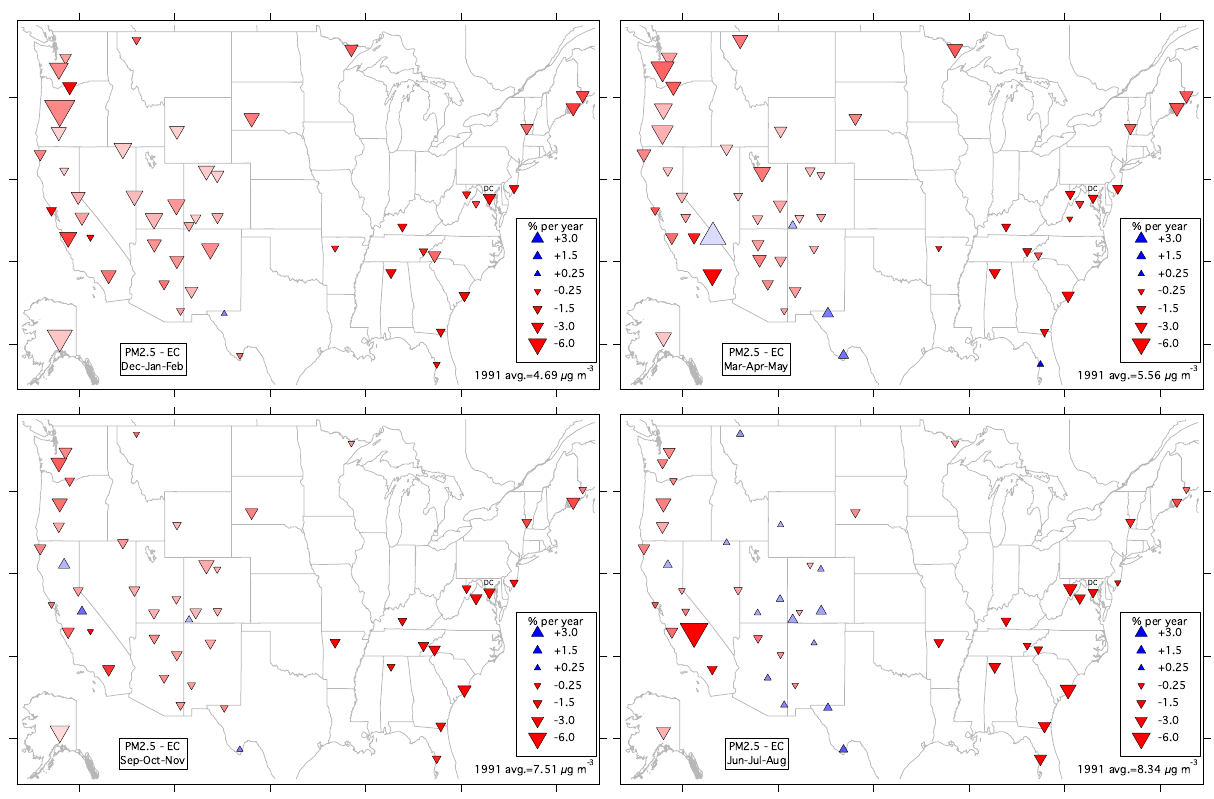
Fig. 4. Quarterly trends in fine mass other than elemental carbon at IMPROVE network sites. Symbols are as in Figs. 2 and